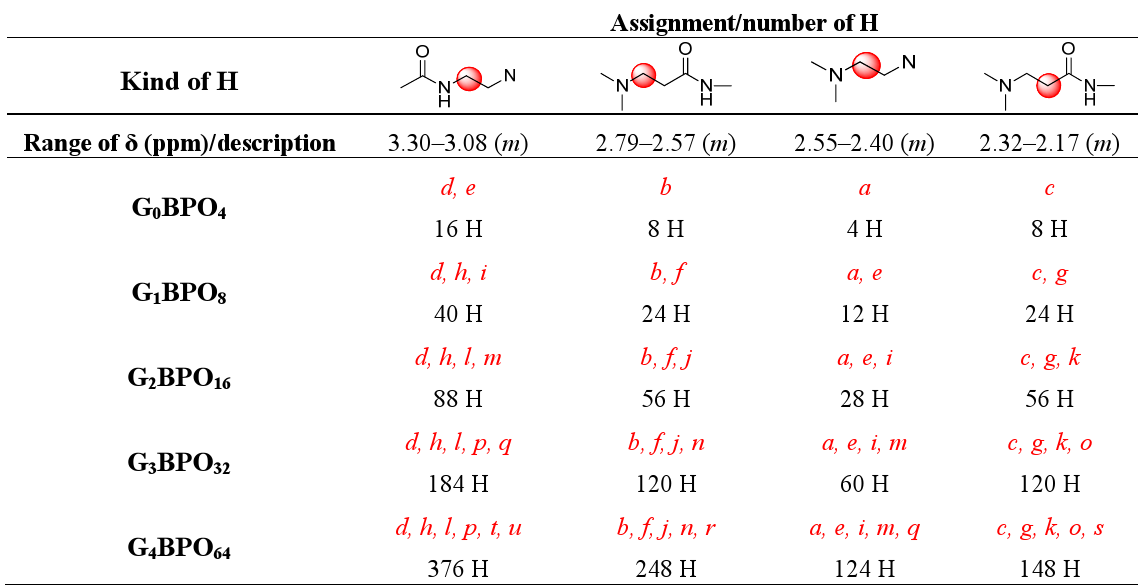
Table 4. 1 H NMR data corresponding to dendritic skeleton in G Kind of H